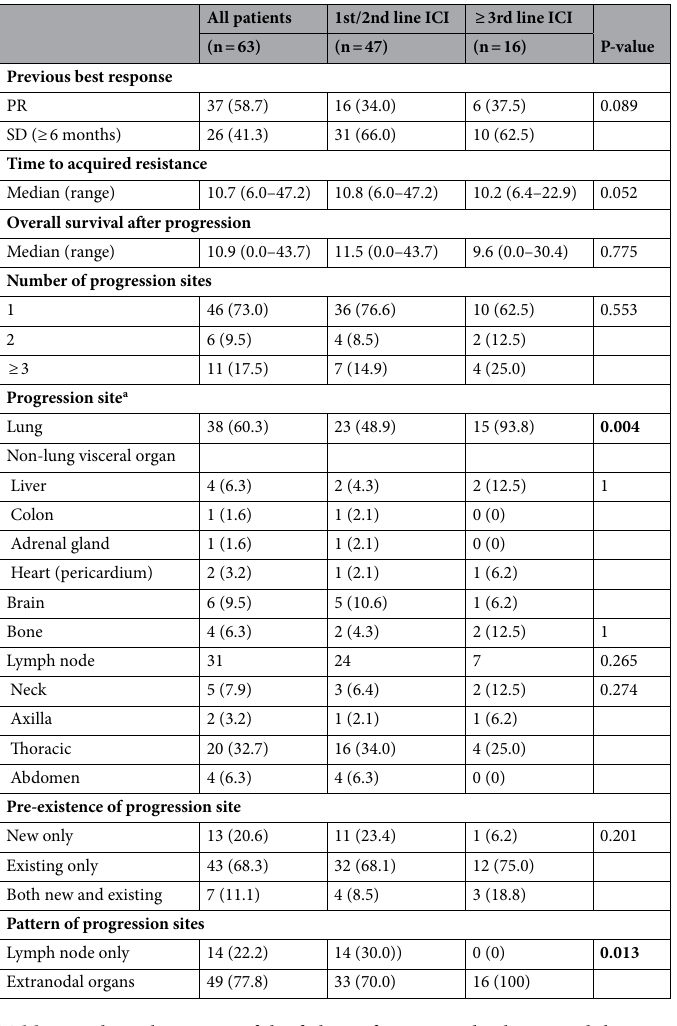
Table 2. Clinical Patterns of the failure of immune checkpoint inhibitors. Bold values denote statistical significance at the p < 0.05 level ICI immune checkpoint inhibitors, PR partial response, SD stable disease. a Patients were included in more than one group based on the site of progression.